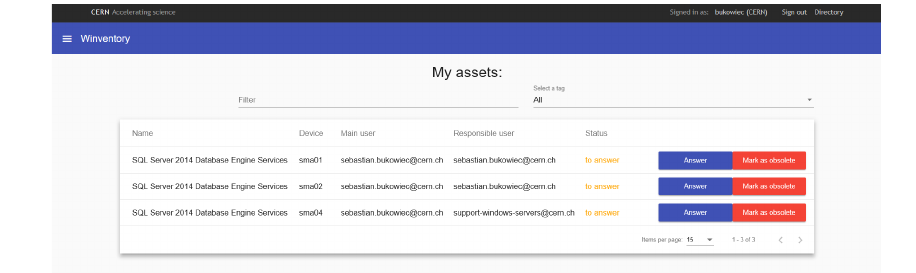
Figure 2. The Winventory application frontend assets view